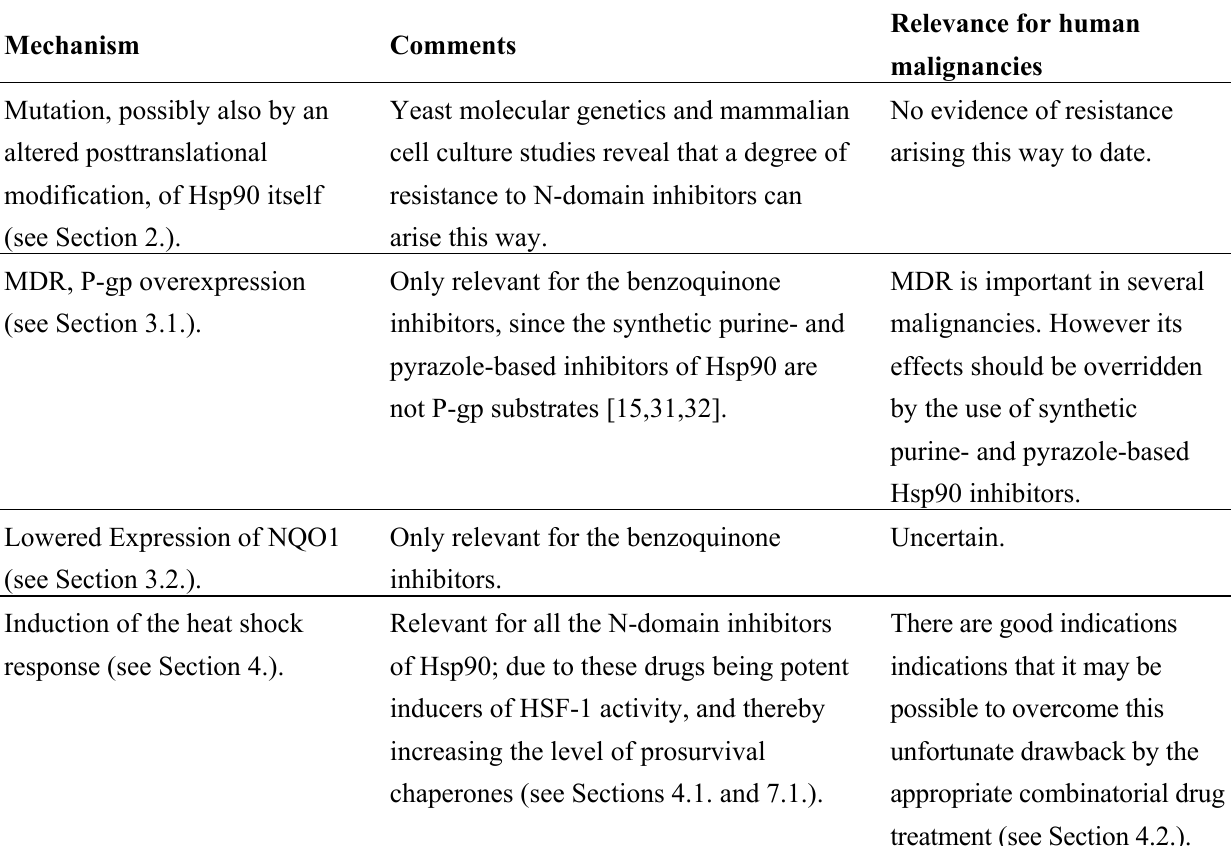
Table 2. Summary of the firmly established mechanisms of N-domain inhibitor resistance.